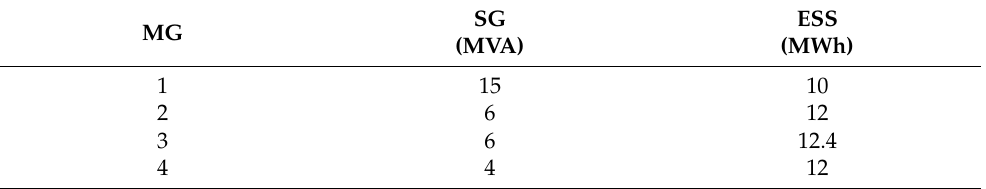
Table 1. MG Generation and storage power